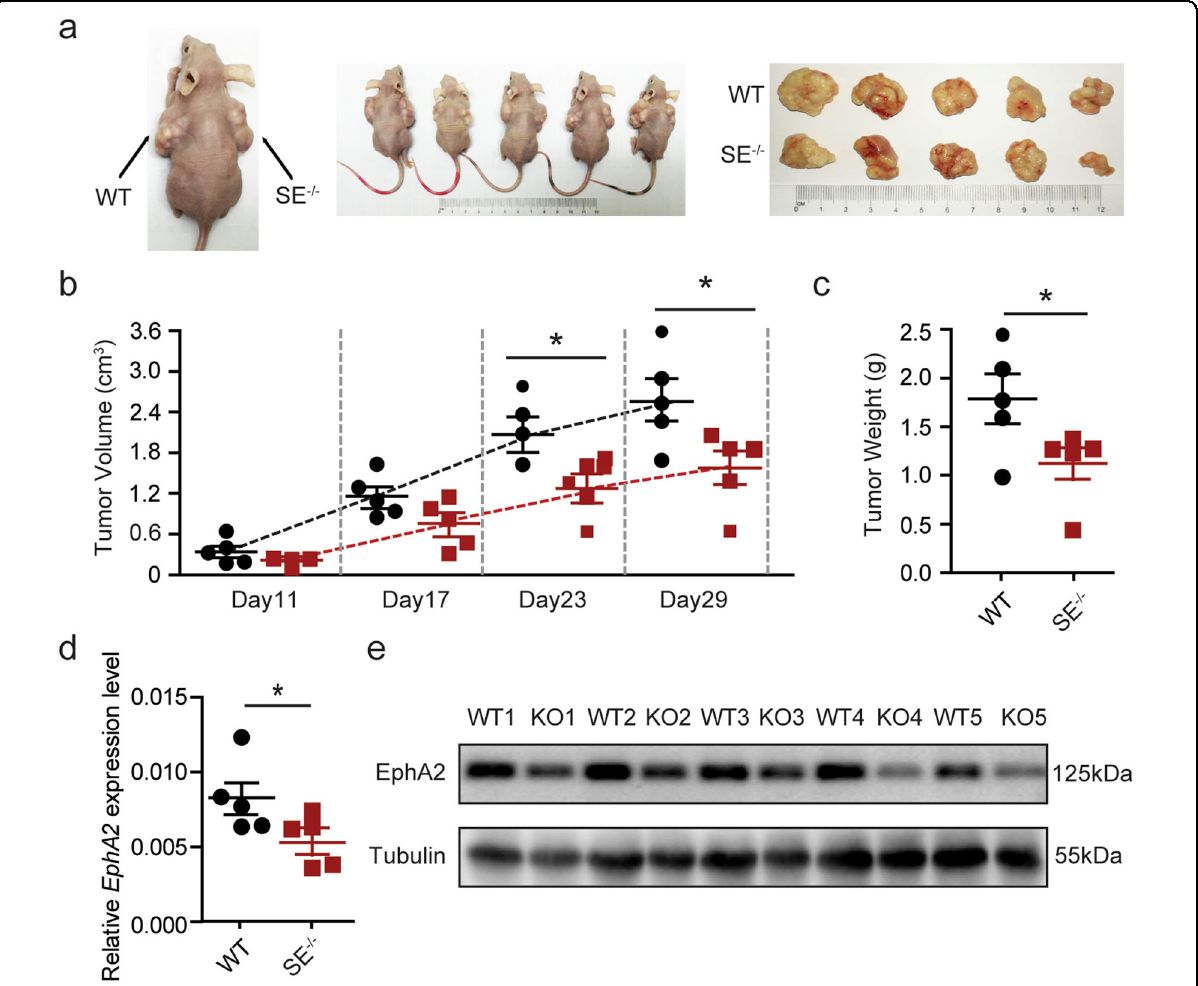
Fig. 5 EphA2-SE deletion inhibited tumorigenesis in vivo. a Homozygous HeLa clone with EphA2-SE deletion was injected into fl anks of nude mice and the representative mice were presented. b Tumor growth curve after the injection of EphA2-SE-de fi cient HeLa cells and control cells into nude mice ( n = 5). c Tumors weight was measured. d , e The expression of EphA2 in tumors was detected by qRT-PCR and western blotting. Error bars, mean ± SD. p values were calculated using t -test. * p <